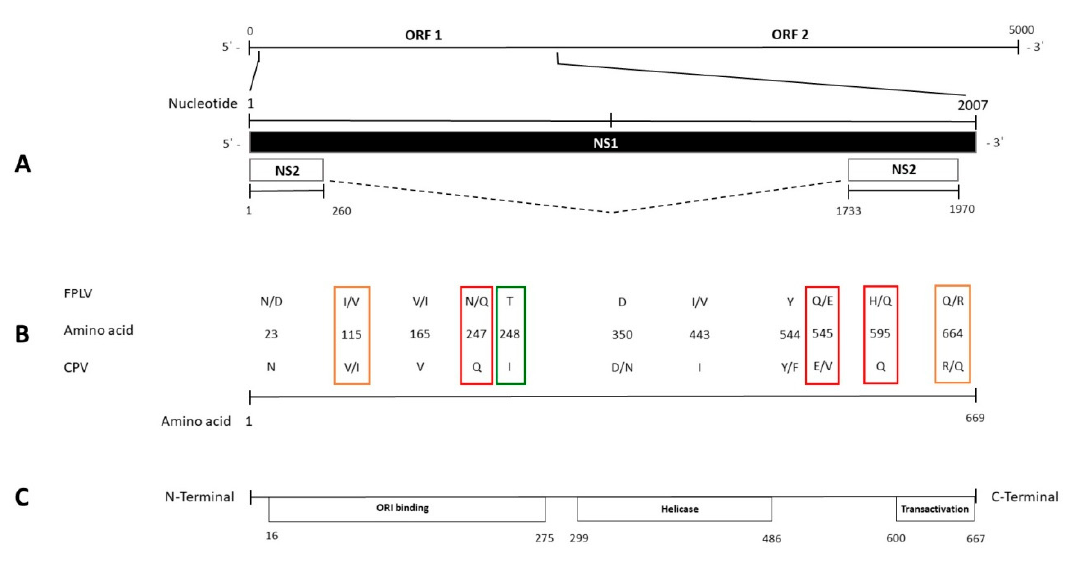
Figure 2. Schematic representation of the FPLV and CPV genome. The scheme, in the upper lines ( A ), represents the complete nucleotide (nt) length of the genome from the 5’ to the 3’ UTR and of the NS1 and NS2 genes. The relative positions of the described amino-acid changes in the NS1 gene sequence are indicated in the middle lines ( B ). The lower line ( C ) represents the location of the potential functional domains within the NS1 gene sequence, extended between the depicted amino-acid residues. Colored squares highlight the amino-acid changes distinguishing FPLV from CPV strains (green) and the convergent amino-acid changes between FPLV and CPV identified in the whole dataset (red) or only among the Italian FPLV strains (orange).